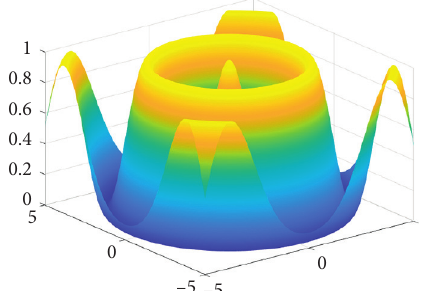
Figure 7: BPNN Schaffer function test